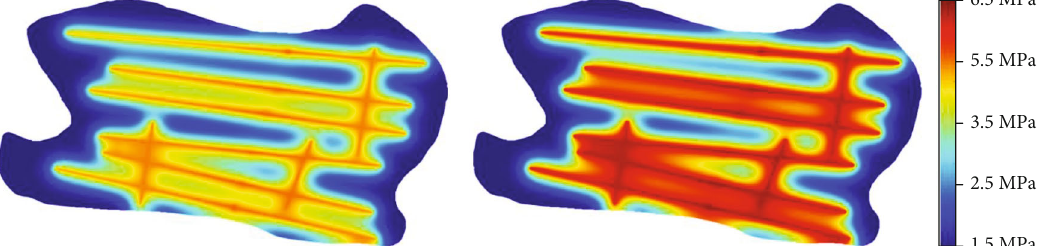
Figure 9: Pressure distribution of the system after 360 days: (a) Constrained injection pressure = 5 : 4 MPa and (b) constrained injection pressure = 6 : 4 MPa.